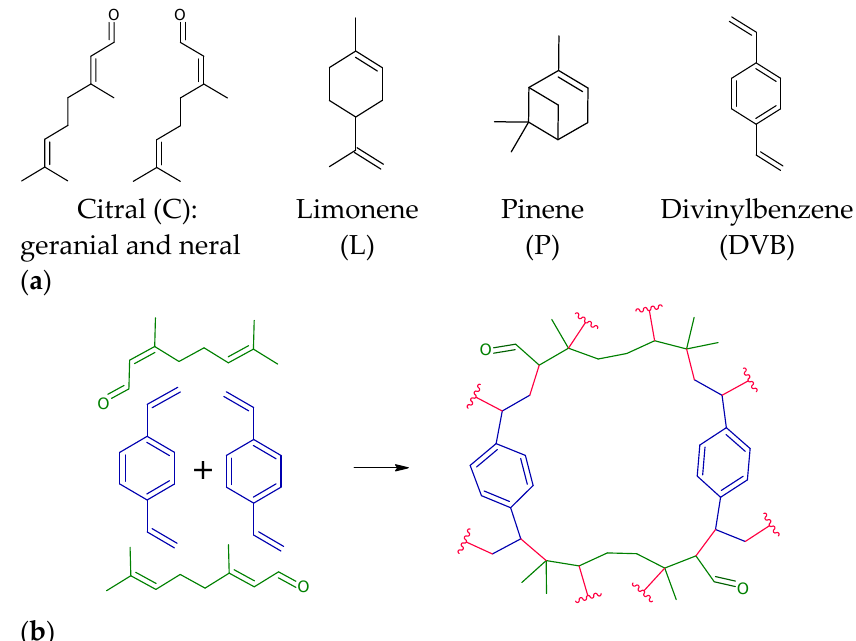
Figure 1. ( a ) Chemical formulas of terpenes/terpenoids monomers and divinylbenzene. ( b ) A hypothetical scheme of polymerization and formation of porosity. Monomers of citral (geranial and neral) are green, and divinylbenzene are blue. In the polymeric structure, the fragments from the appropriate monomers are marked with relevant colors, and the newly formed bonds are marked in